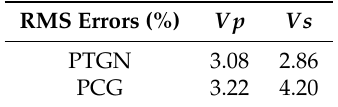
Figure 7. Multiparameter inversion results: ( a ) Vp and ( b ) Vs using PCG, and ( c ) Vp and ( d ) Vs using PTGN. Table 1. Root mean square (RMS) errors of inversion results using PCG and